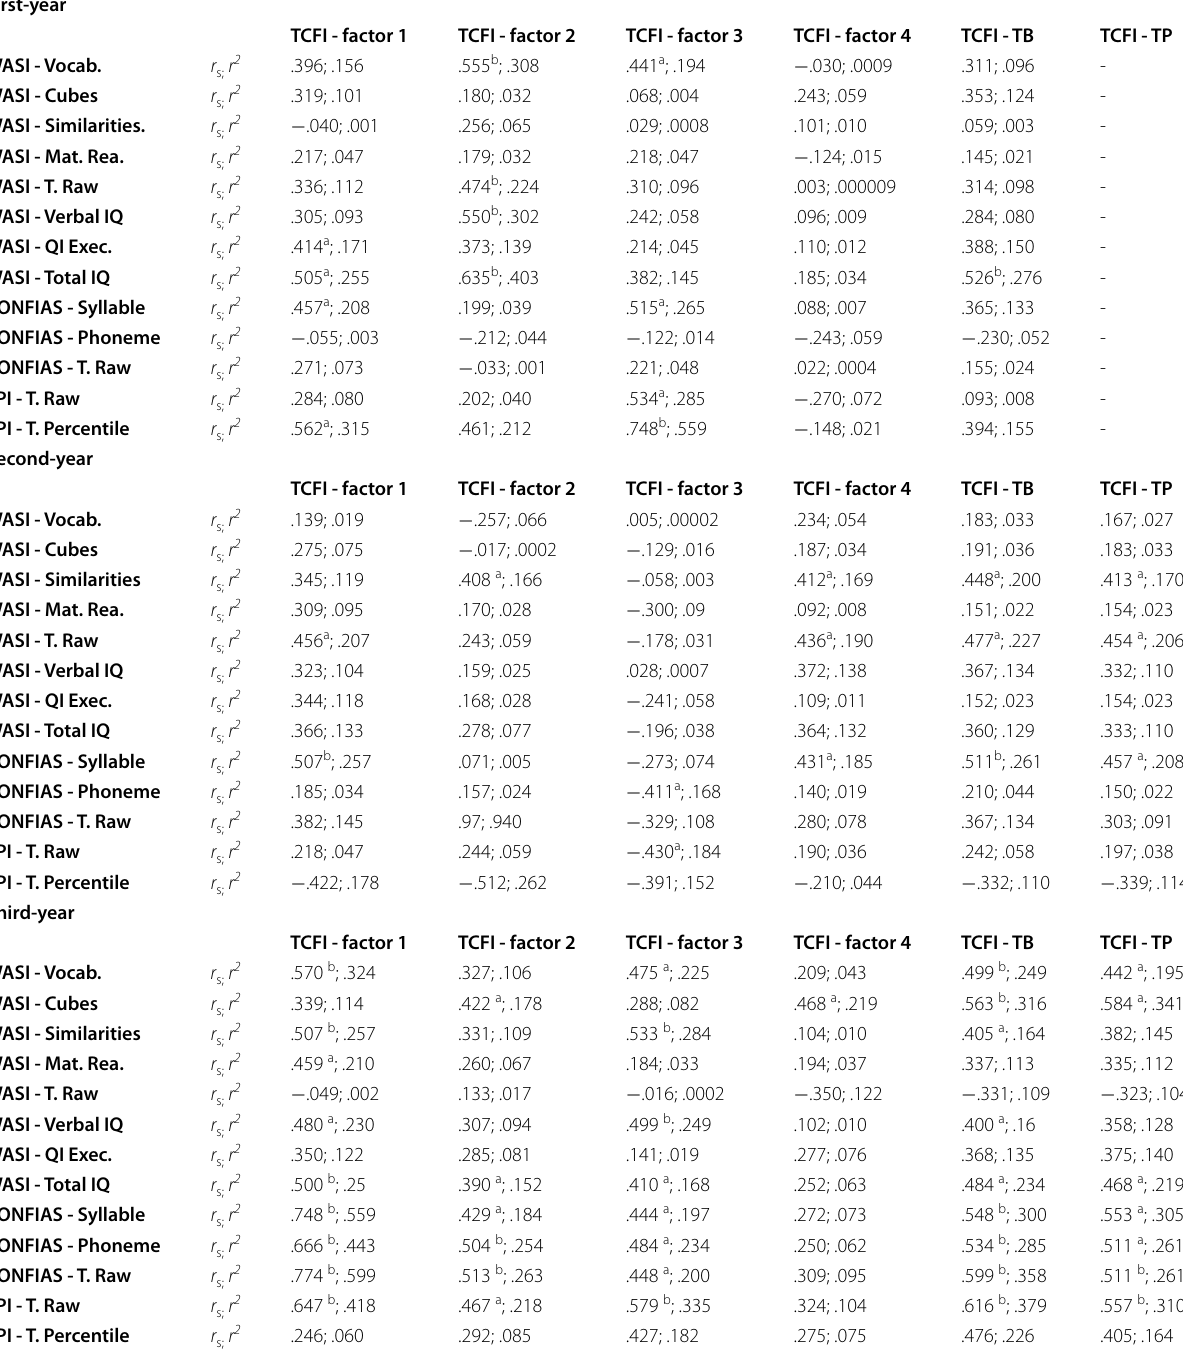
r s , Spearman’s correlation coefficient; a significant value; b very significant value; r 2 , correlation squared; TB , raw total; TP , total